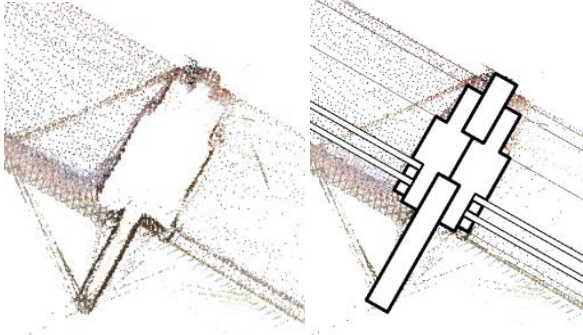
Figur 10. Data captured from the TLS survey (left) and the actual complexity of the structure (right). Pierre Jouan